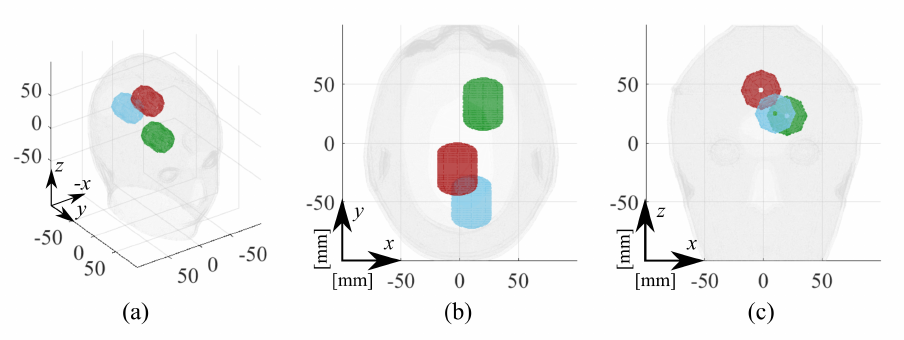
Figure 6. MTP estimated stroke positions in the experimental testing: 1, blue capsule; 2, red capsule; and 3, green capsule. ( a ) Three-dimensional view, ( b ) transverse view, and ( c ) frontal